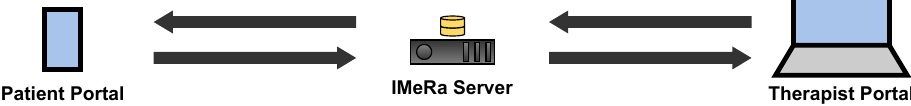
Figure 19. Architecture of the questionnaire